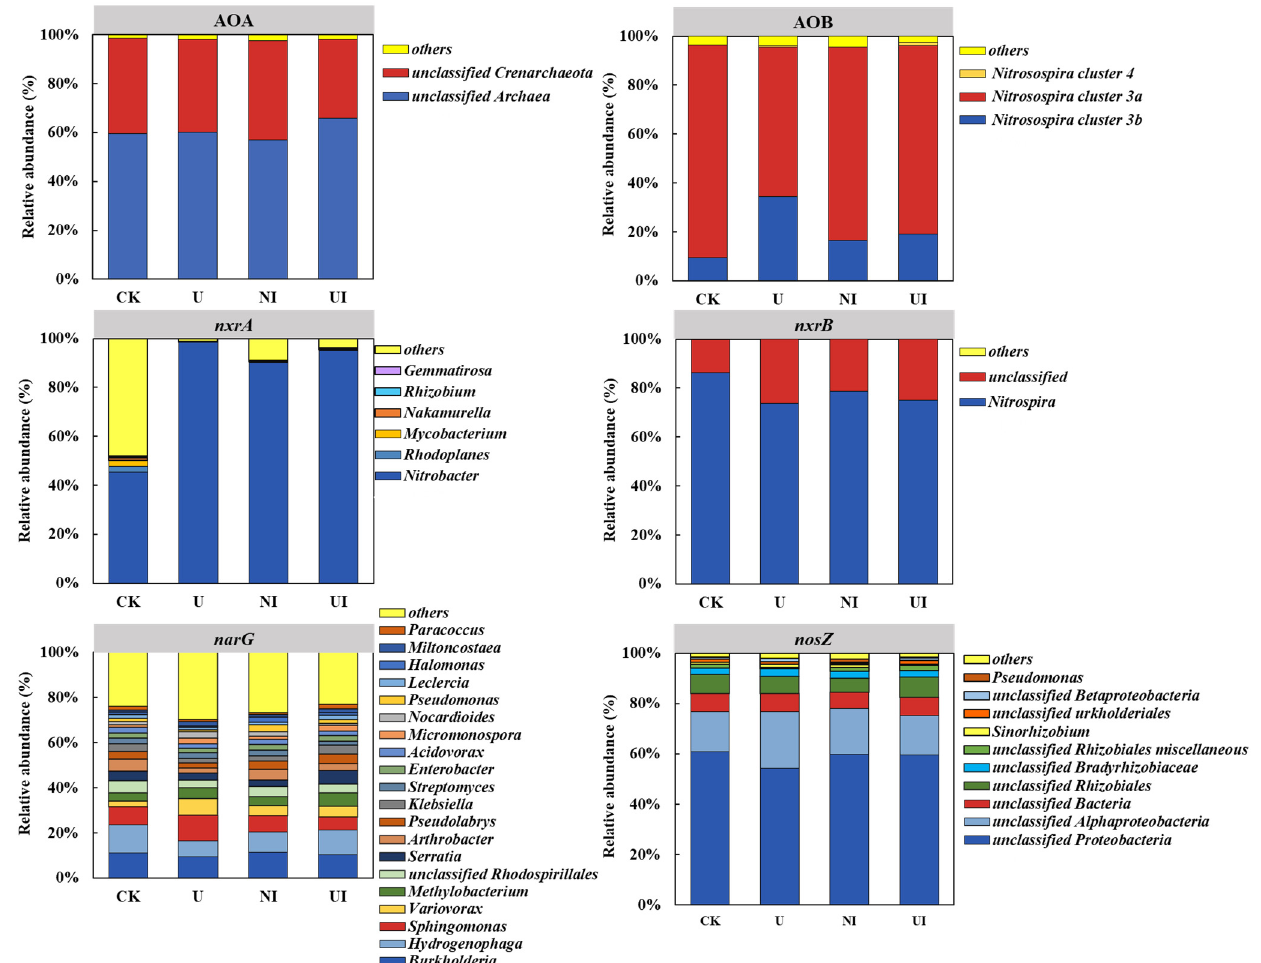
Figure 4. The relative abundance of AOA, AOB, nxrA -bearing, nxrB -bearing, narG -bearing, and nosZ -bearing bacterial populations across four treatments on the genus level (relative abundance > 0.01%). Treatments were as follows: CK: no nitrogen fertilizer application; U: urea; UI: urea with NBPT; and NI: urea with DMPP.